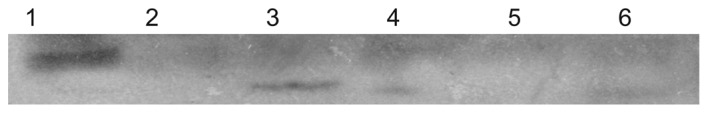
Co-immunoprecipitation and western blot anlaysis were performed to detect interactions between X or X mutant proteins with cytochrome c oxidase subunit III (COXIII) in COS7 cells. Lane 1, western blot analysis using hemagglutinin (HA) antibody shows that a protein of approximately 17 kDa (the predicted size of HA-X) was co-immunoprecipitated with v-myc myelocytomatosis viral oncogene homologue (Myc) antibody from an extract of COS7 cells containing HA-X and Myc-COXIII fusion proteins; lane 2, western blot analysis of an extract from COS7 cells transformed with pCMV-HA-X 1 and pCMV-Myc-COXIII plasmids; lane 3, western blot analysis using HA antibody showing a protein of approximately 14 kDa (the predicted size of HA-X2) was co-immunoprecipitated with Myc antibody from an extract of COS7 cells containing HA-X2; lane 4, western blot analysis of an extract from COS7 cells transformed with plasmids pCMV-HA-X and pCMV-Myc; lane 5, western blot analysis of an extract from COS7 cells transformed with plasmids pCMV-HA and pCMV-Myc; lane 6, western blot analysis of an extract from non-transfected COS7 cells.